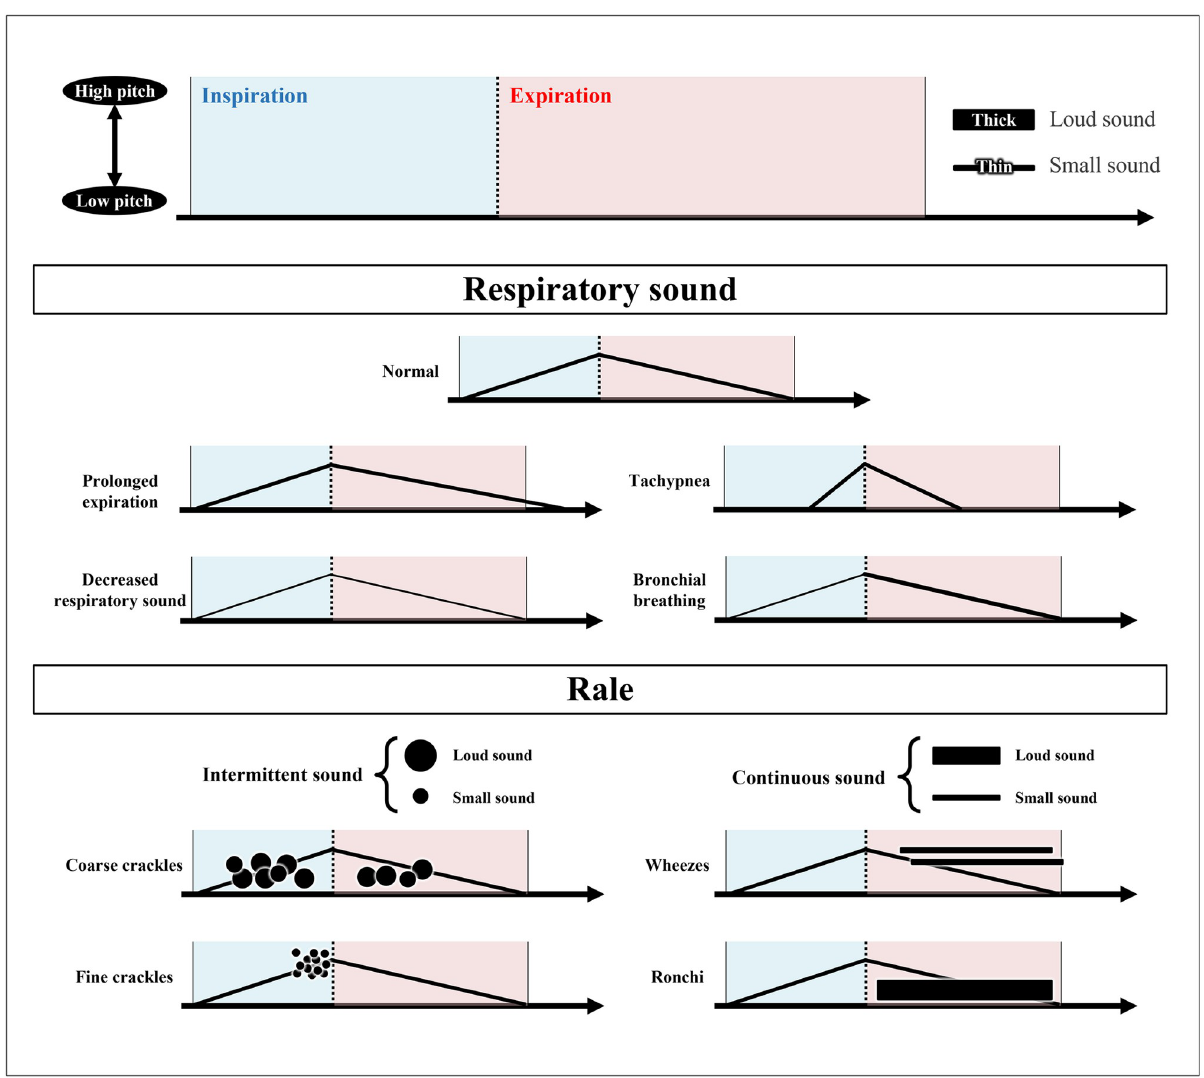
Fig 2. The graphical visualization of lung sounds using a combination of lines and circles. A diagram showing inspiration and expiration was used to visualize the lung sounds. In the diagram, the vertical axis represents the pitch of lung sounds and the horizontal axis represents the duration of lung sounds. For respiratory sounds, the thickness of the line represents the loudness of the sound. For the intermittent rales, each crackle is represented by a circle, the height of position indicates the sound’s pitch, and the circle’s size indicates the loudness of the sound. Thus, coarse crackles are presented as circles drawn at a lower position on inspiration and/or expiration. Fine crackles are presented as circles that are drawn at the end of the inspiration and are concentrated at a high position. For continuous rales, a horizontal bar was used. The height of the position of the horizontal bar indicates the pitch of the sound, and the thickness of the bar indicates the loudness of the sound. Wheezes are mainly represented by a horizontal bar at the high end of the expiration and rhonchi are also mainly represented by a horizontal bar at the low end of the expiration.